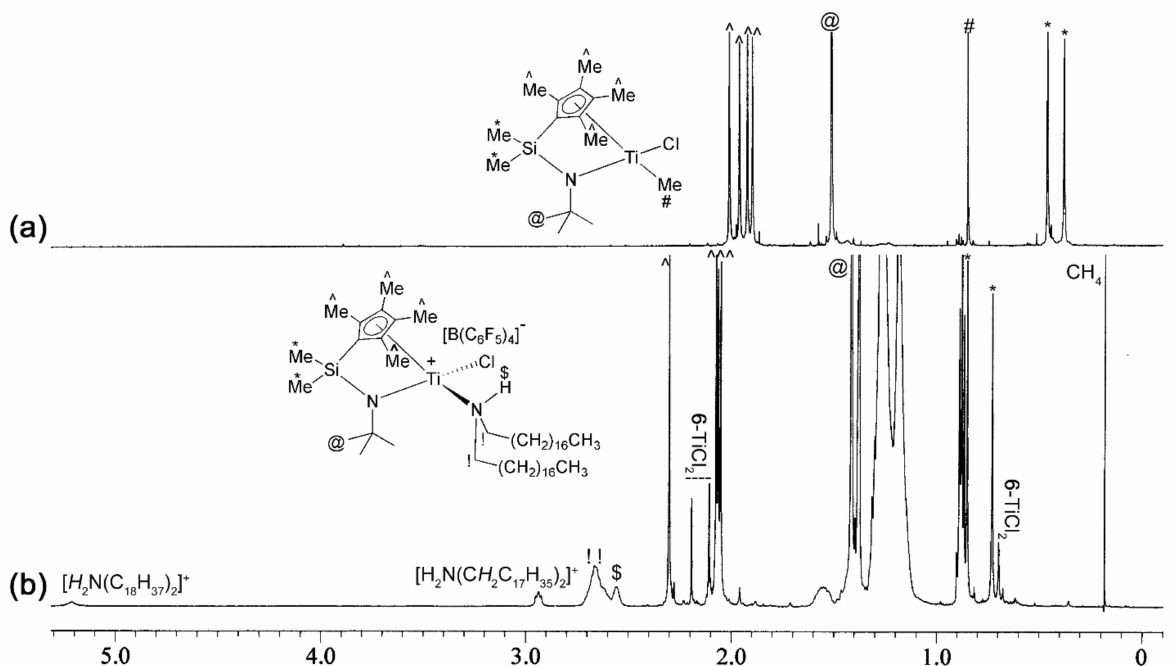
Figure 7. 1 H NMR spectra of 5 -TiCl(Me) ( a ) and its activated complex [ 5 -TiCl(N(H)(C 18 H 37 ) 2 )] + [B(C 6 F 5 ) 4 ] − ( b ). Signals marked with !, $, ˆ, @, #, and * characters correspond to protons marked with those characters in the